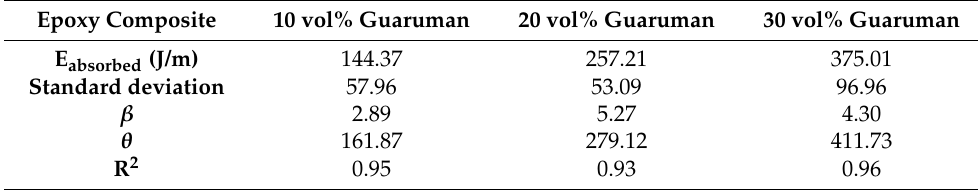
Figure 4. Weibull frequency distribution graph for the epoxy composites with different volume fractions of guaruman fiber: ( a ) 10, ( b ) 20, and ( c ) 30 vol%. Table 1. Weibull parameters for the impact resistance of guaruman fiber epoxy composites.